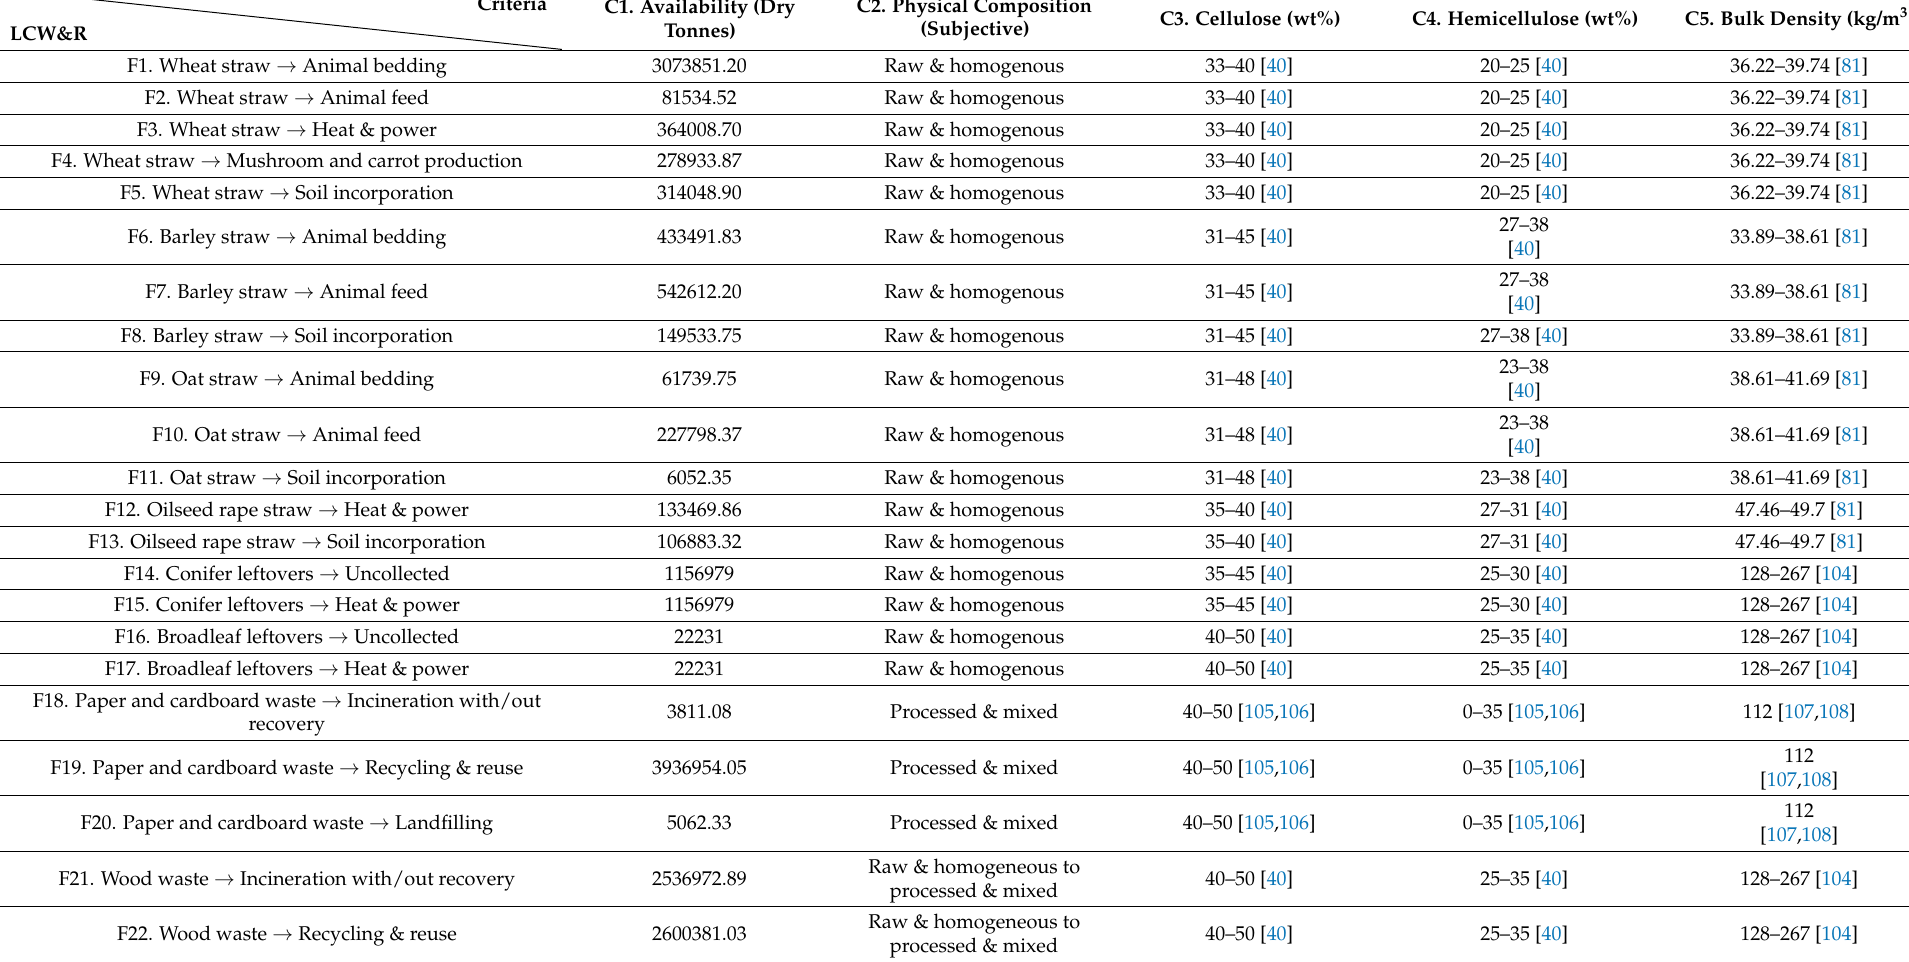
Table 5. Positive criteria (C1–C5) values for LCW&R streams in the